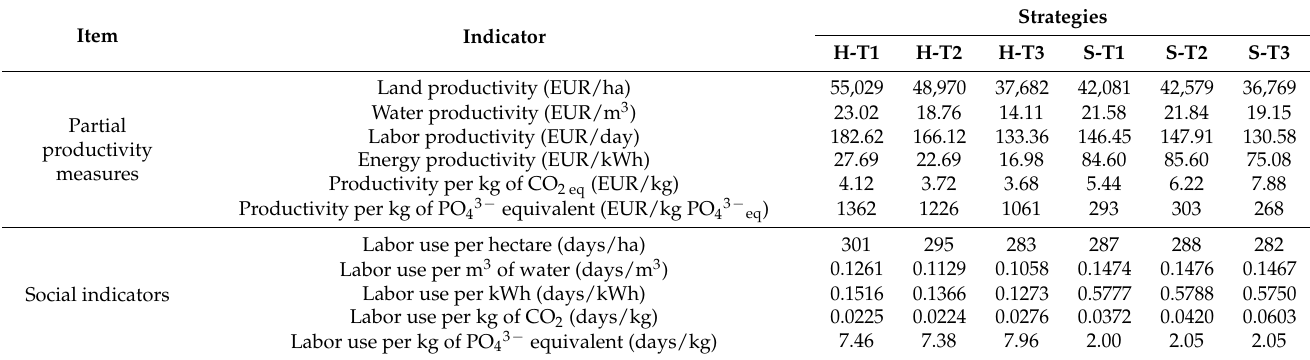
Table 5. Average values of productivity measures and social indicators for the different